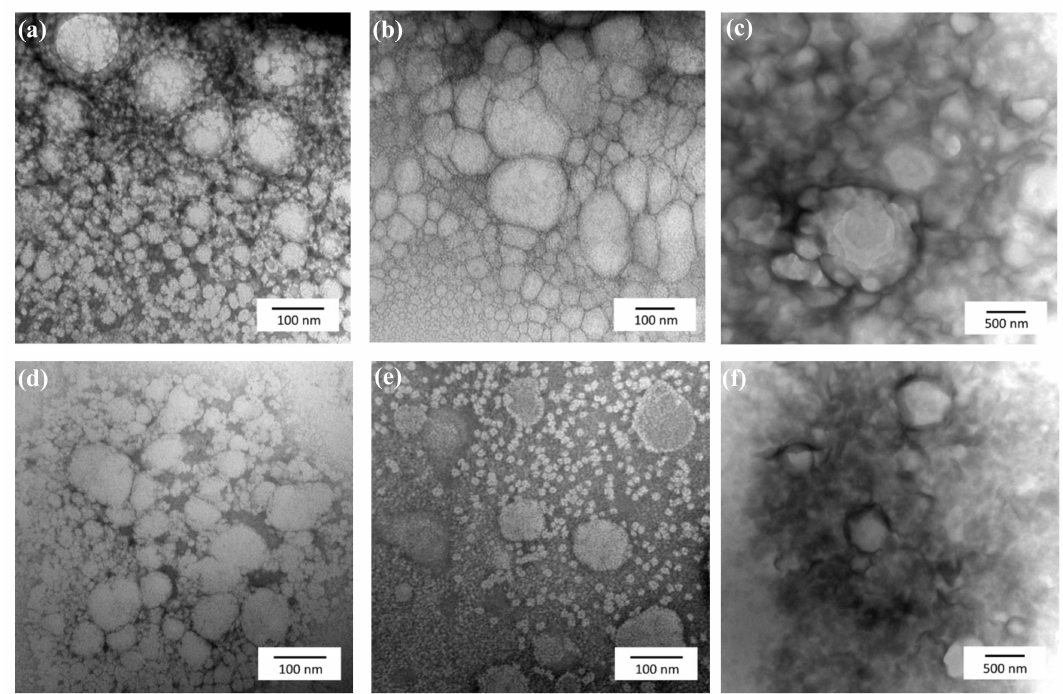
Figure 1. TEM images of Apig incorporated into BSFL oil NEs with SOR 60%, oil content 1%, and surfactant ratios of HL/TPGS = ( a ) 0/100, ( b ) 50/50, and ( c ) 100/0. TEM images of Apig incorporated into AV oil NEs with the same composition ratios as described above as surfactant ratios of HL/TPGS = ( d ) 0/100, ( e ) 50/50, ( f )